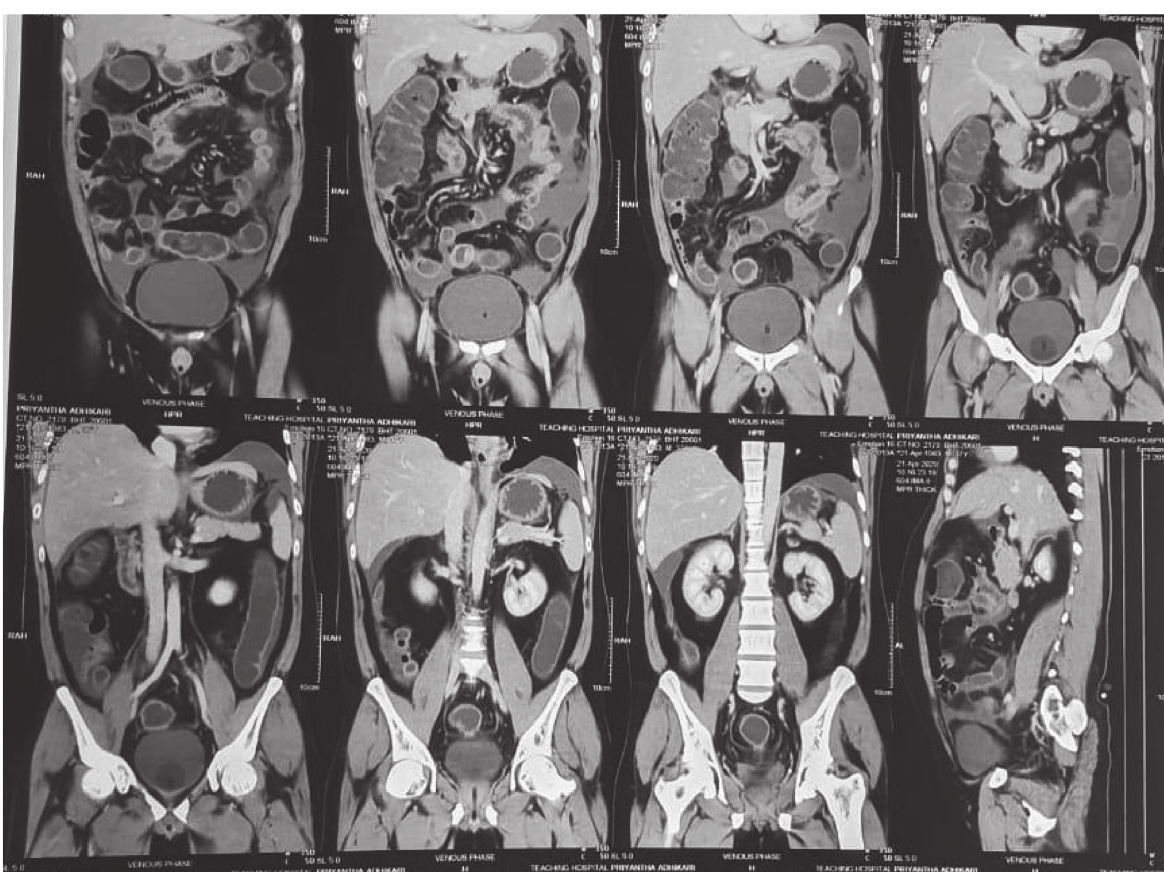
Figure 1: Coronal reconstructed images of the abdomen and